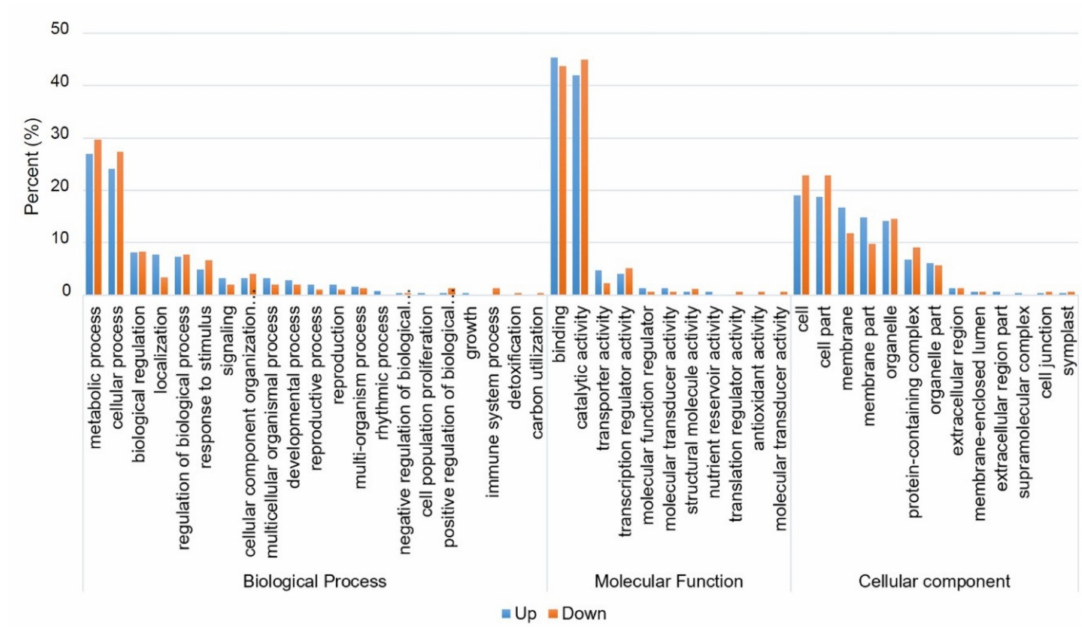
Figure9. Geneontology(GO)classificationofdi ff erentiallyexpressedgenes(DEGs)undersalttreatment. GO enrichment analysis for upregulated and downregulated genes after salt treatment. The results are divided into three main categories: molecular function, biological process, and cellular component. The Y-axis indicates the percentage of genes in the upregulated and downregulated